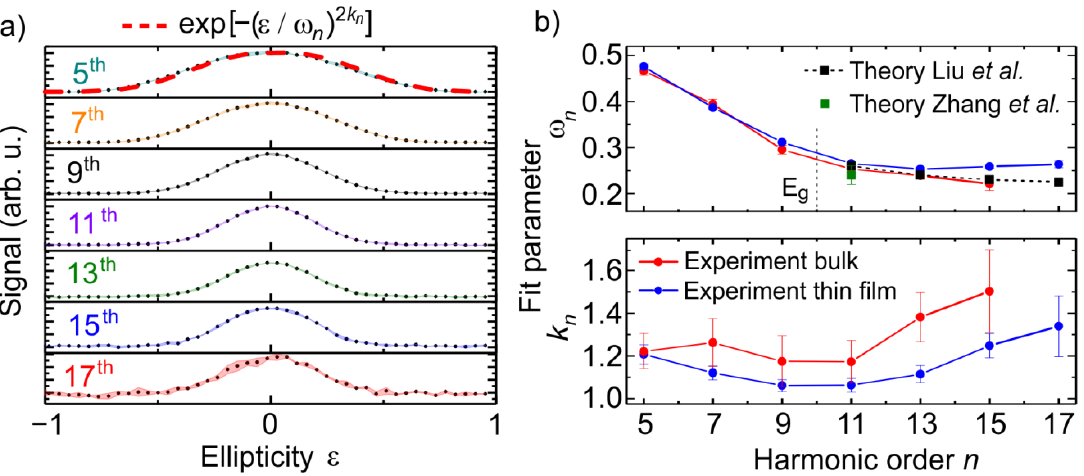
Figure 3. Dependence of HHG in ZnO on the laser ellipticity for a laser intensity of 0.39 TW/cm 2 . ( a ) Spectrally integrated emission of the 5th up to the 17th harmonic from the ZnO thin film sample. ( b ) Upper panel: Comparison of the experimentally determined sensitivity of the detected harmonic orders n on the laser ellipticity, described by ω n , with theoretically determined values from Liu et al. [22] and Zhang et al. [23]. Lower panel: Fit parameter k n as a function of the detected harmonic order n from the bulk (red) thin film sample (blue).